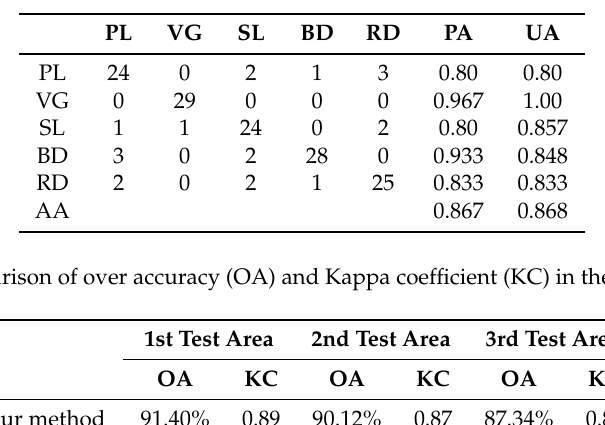
Table 21. Confusion matrix of the RFs in the third area.